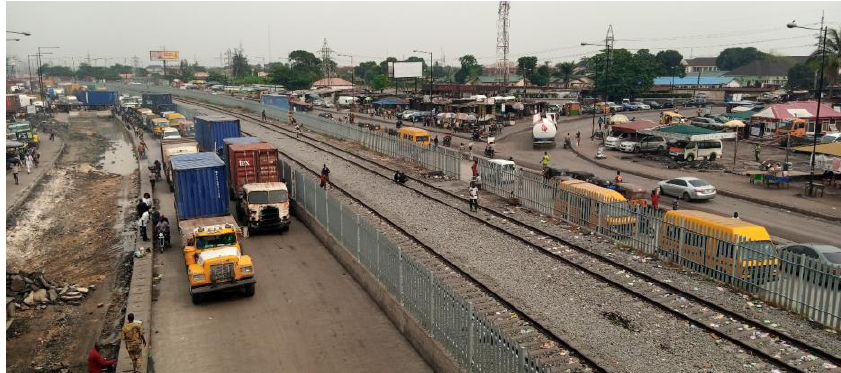
Fig. 8. Expansion of the Lagos-Badagry Expressway with embedded light rail at Mile 2